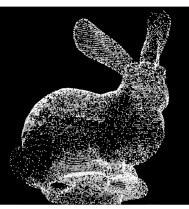
Figure 11. The simplification point cloud at a simplification ratio of 15.6%.